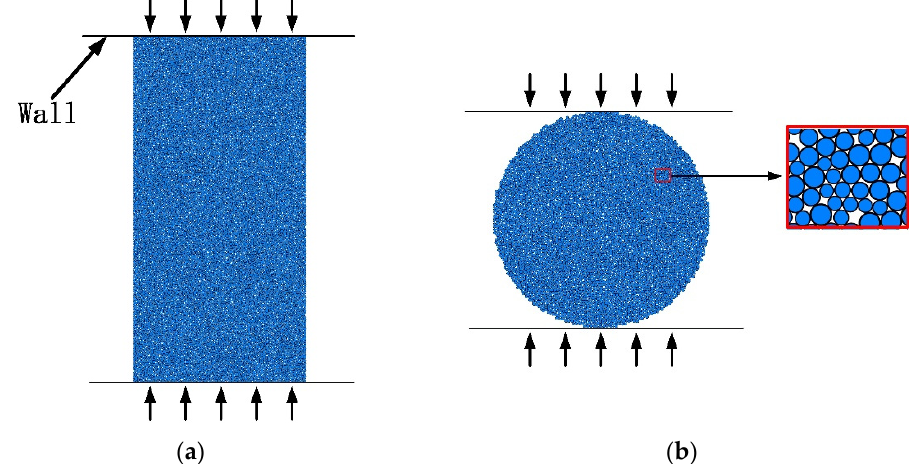
Figure 8. Discrete element model: ( a ) Uniaxial compression test model. ( b ) Brazilian splitting test model.